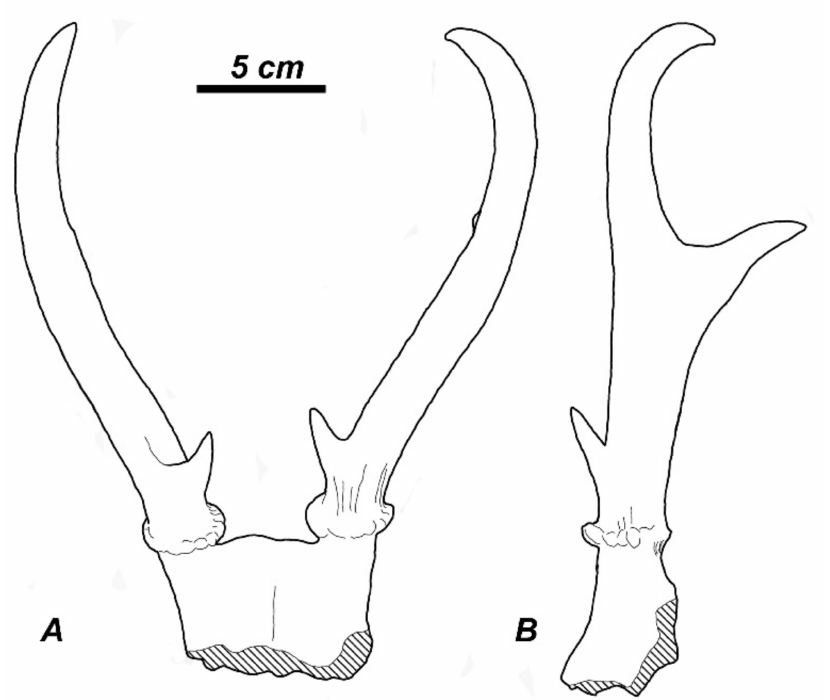
Figure 7. Metacervulus capreolinus from the late Tertiary of China (holotype), a possible forerunner of the genus Odocoileus : ( A ), frontal view; ( B ), lateral view of left antler (adapted from Teilhard de Chardin and Trassaert